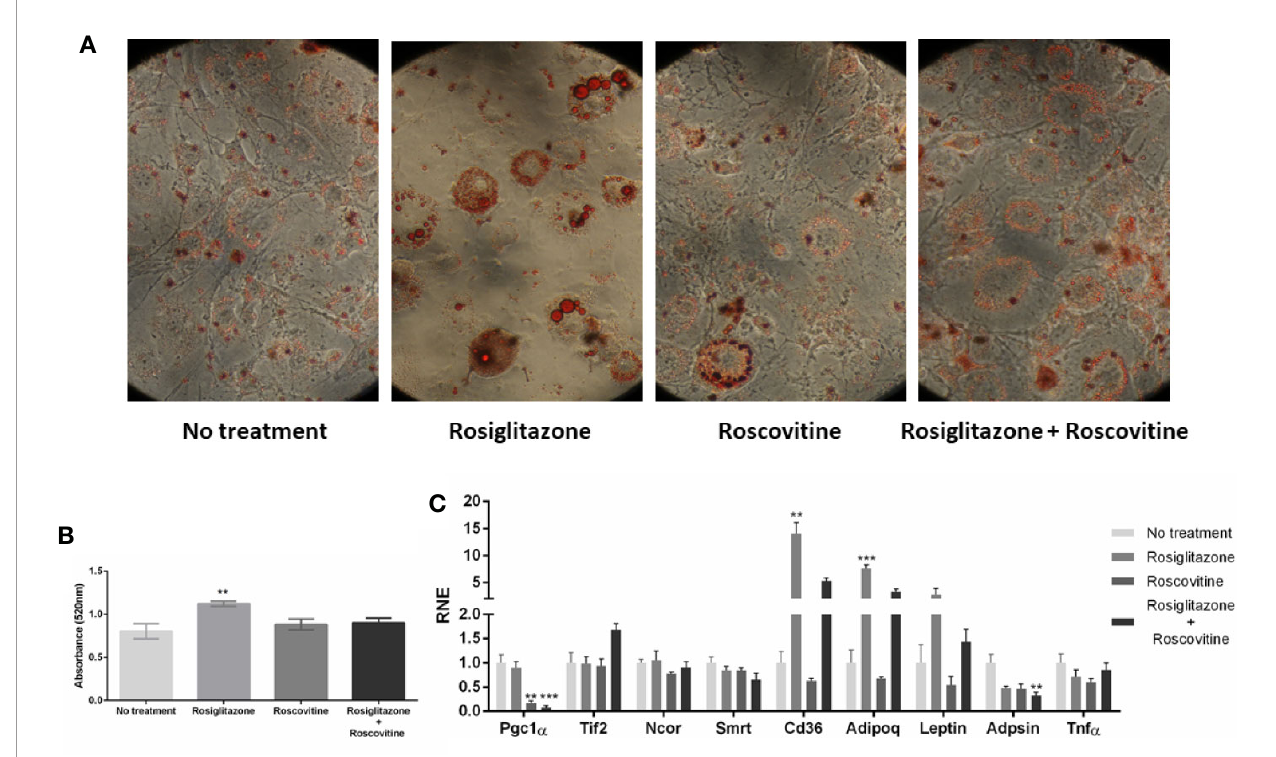
FIGURE 5 | Adipocyte differentiation in different states of PPAR g phosphprylation. (A) Images of the 8th day of treatment for differentiation into adipocytes. 3T3-L1 cells after 7 days of treatment with differentiation cocktail stained with Oil Red O in 40× lens. During the differentiation process, were added1 m M of Rosiglitazone, 10 m M of Roscovitine, or both treatments. (B) Absorbance measurement of differentiated cells into adipocytes. After each treatment, the cells were stained with Oil Red O and the absorbance was measured by a spectrophotometer. Statistical differences were measured by one-way ANOVA, comparing the different treatments, values of p < 0.05/** 0.001/*** 0.001. The treatment with Rosiglitazone showed greater absorbance, therefore a higher level of differentiation. (C) Gene expression of genes of the studied coregulators, and some of the PPAR g regulated genes that were reported be dysregulated by S273 phosphorylated state (Cd36, Adipoq, Leptin, Adpsin, and Tnf- a ). The statistical analysis was performed by Kruskal-Wallis test (non-parametric), followed by the Dunn post hoc test comparing the untreated condition with each one of treated conditions. P values: p ≤ 0.01**; p ≤